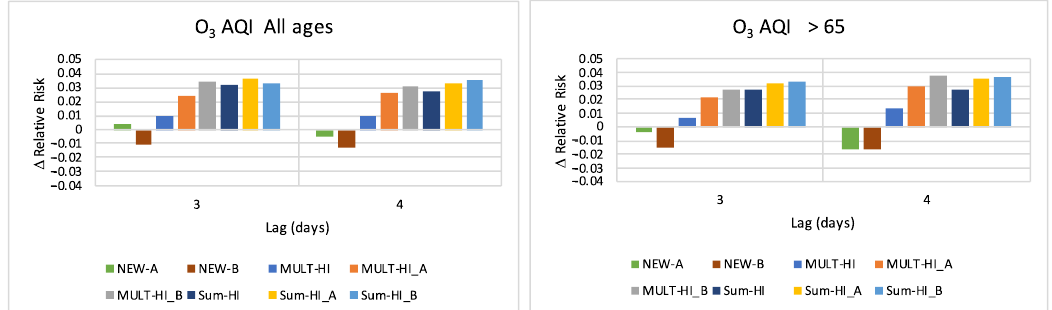
Figure 5. The increase in the interquartile relative risk over the baseline (AQI-only) model, for lags of three and four days. Model characteristics are described in Table 1.